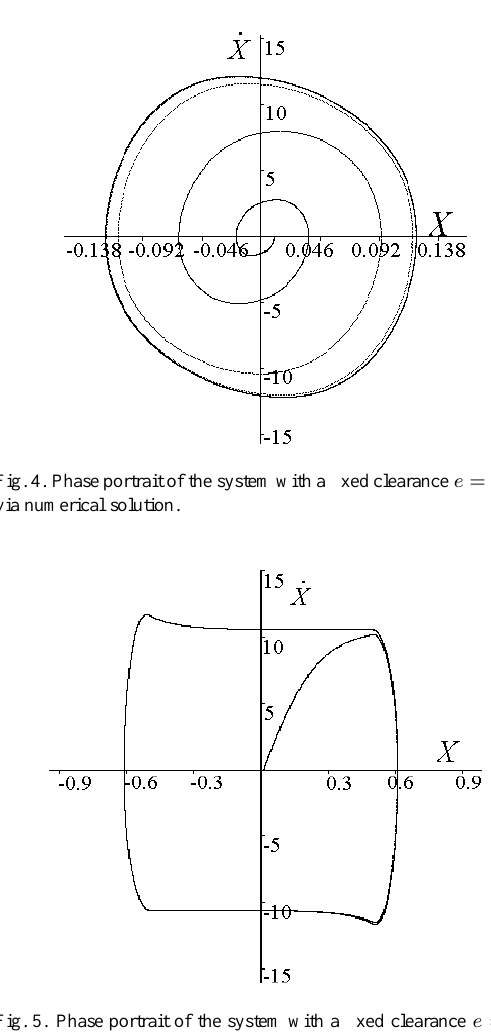
Fig. 5. Phase portrait of the system with a fixed clearance e = 0 . 5 via numerical